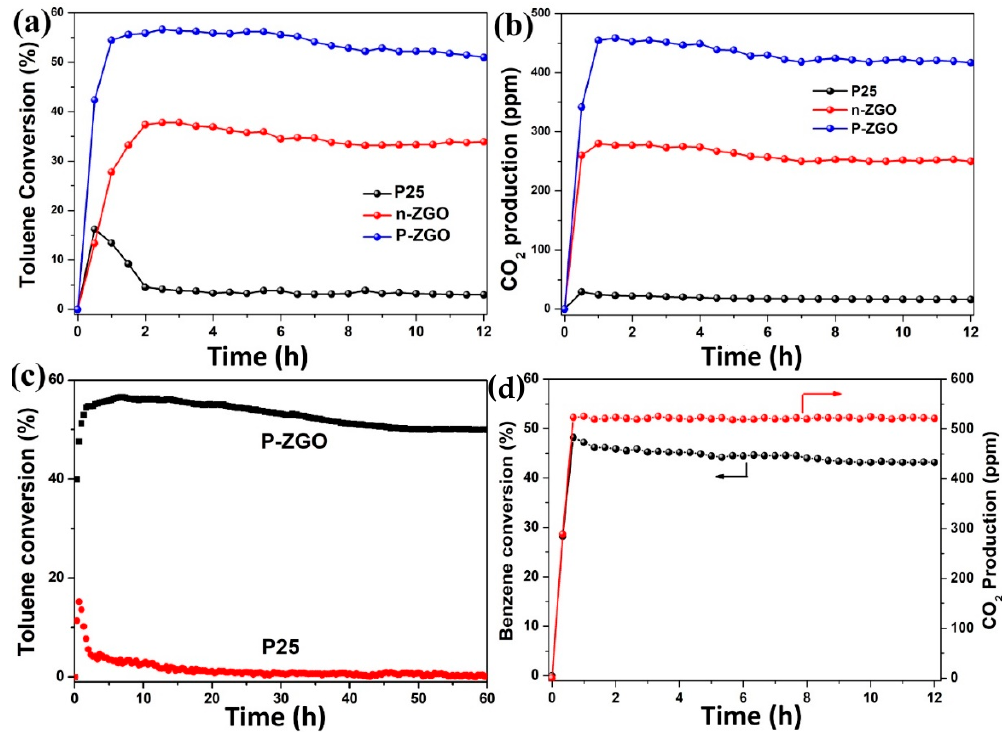
Figure 5. ( a ) The photocatalytic conversion of toluene, ( b ) the concentration of produced CO 2 , and ( c ) the stability test of different samples. ( d ) The photocatalytic conversion of benzene and the the stability test of di ff erent samples. ( d ) The photocatalytic conversion of benzene and the concentration concentration of produced CO 2 over P-ZGO. of produced CO 2 over P-ZGO.